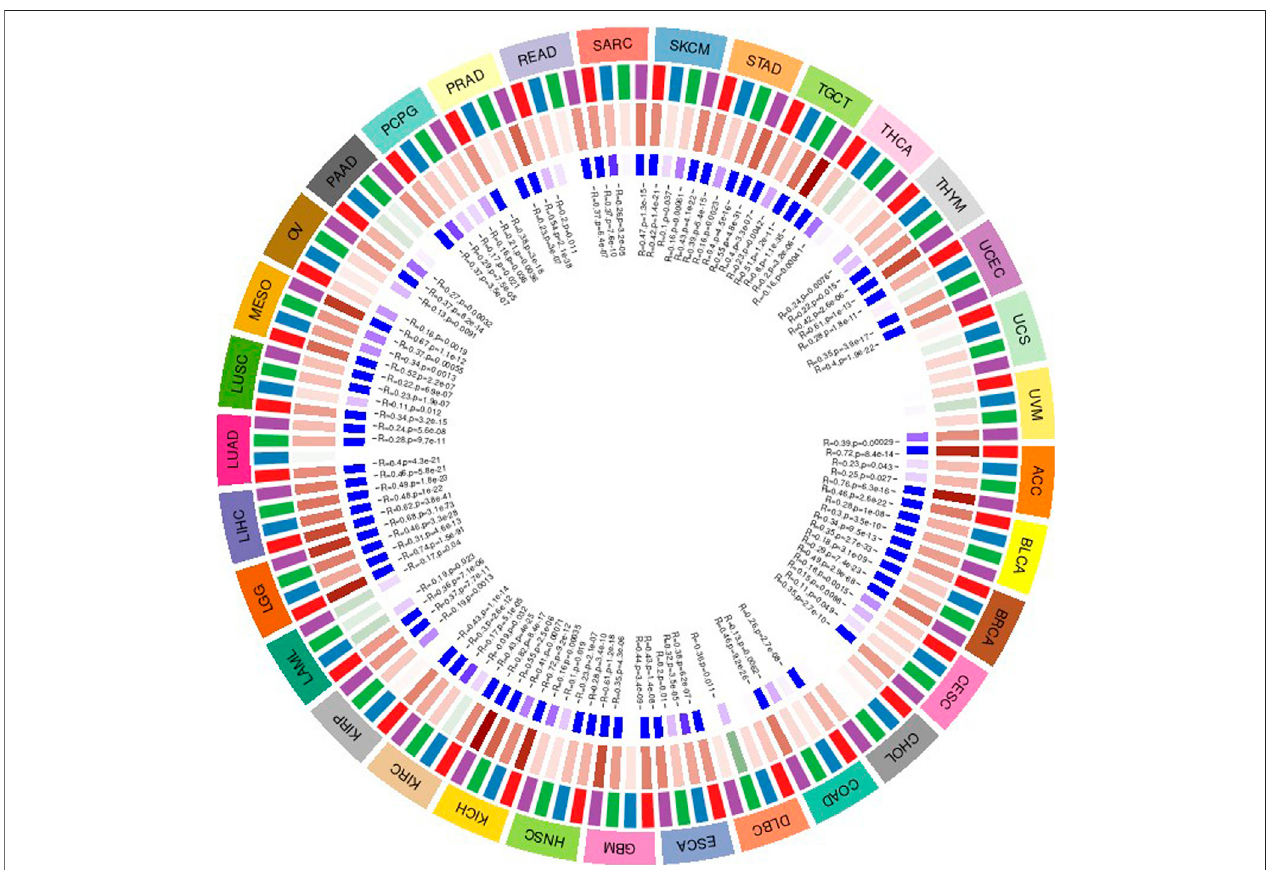
FIGURE 14 | The association between value of genes and the expression of four methyltransferases.